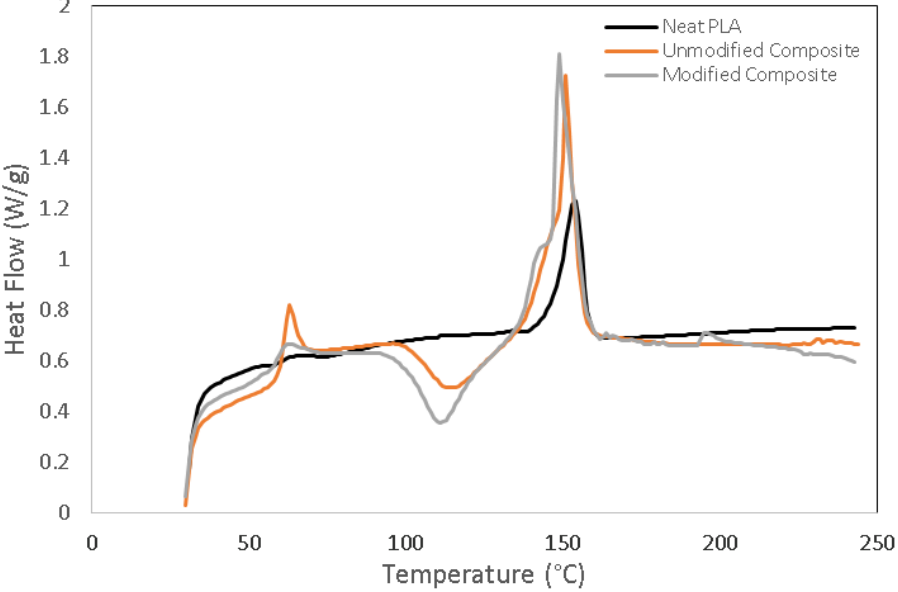
Figure 8. Differential scanning calorimetry (DSC) curves of unmodified and modified PLA/chitosan biocomposites at different fiber contents. Table 4. DSC data obtained for unmodified and modified PLA/chitosan biocomposites.